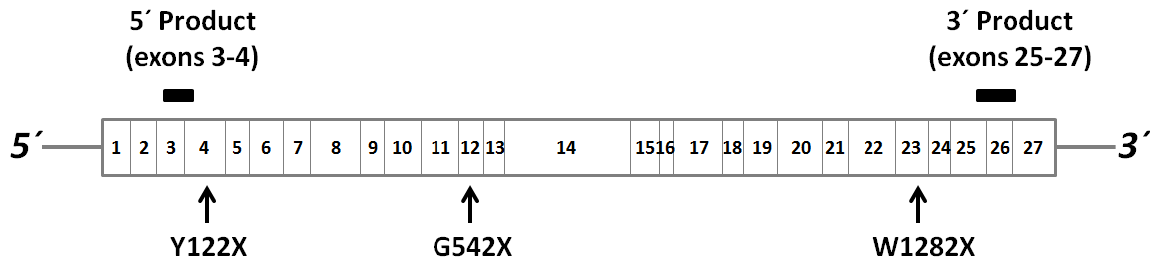
Figure 1. Positions of 5 ′ and 3 ′ PCR products amplified from CFTR cDNA in the present study (black bars). The positions of the three PTC mutations studied are also shown. The currently used CFTR exon numbers are given, according to the CFTR mutation database [3].